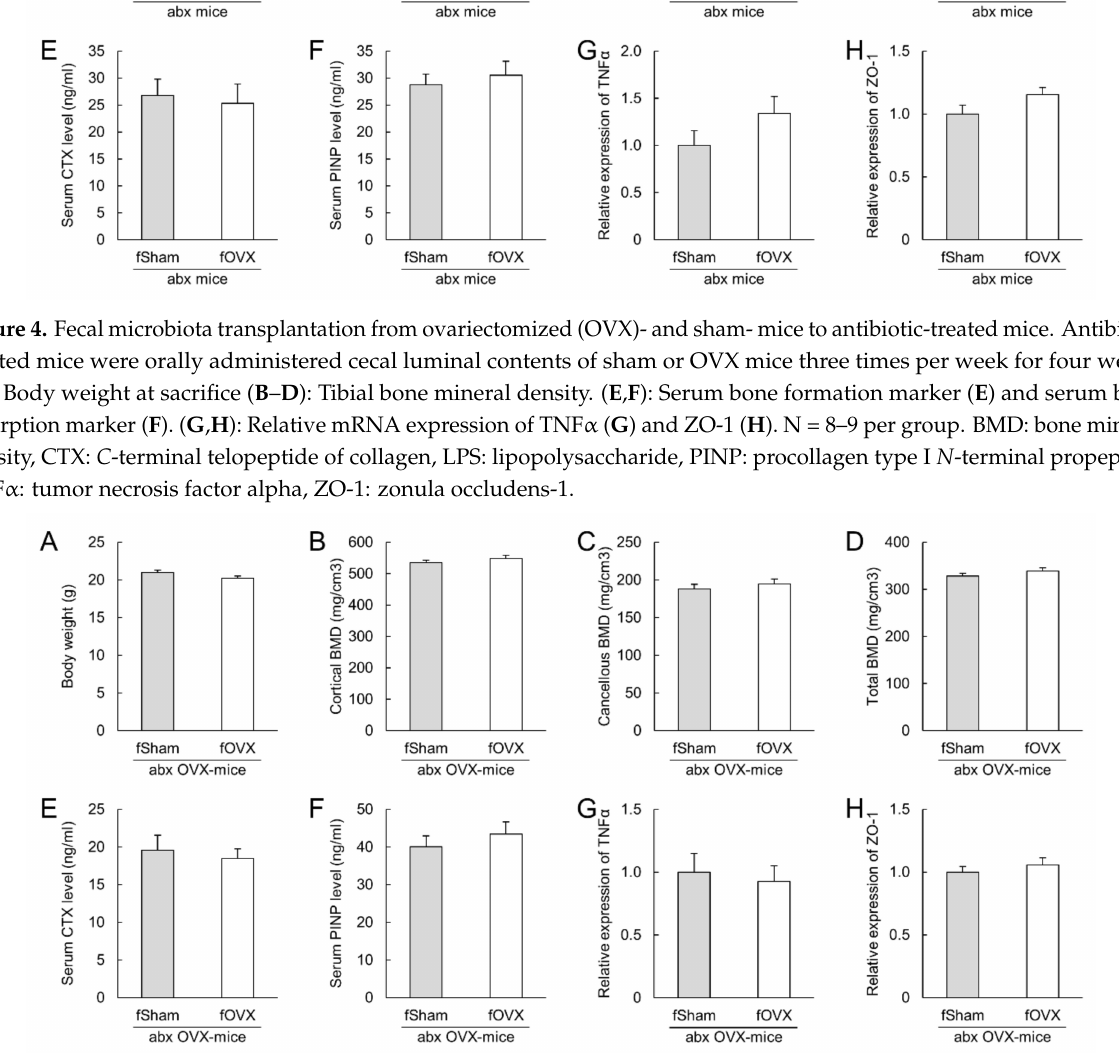
Figure 5. Fecal microbiota transplantation from ovariectomized and sham mice to antibiotic-treated ovariectomized mice. Antibiotic-treated mice were ovariectomized and orally administered cecal luminal contents of sham and ovariectomized mice three times per week for four weeks. ( A – F ): Body weight, tibial bone mineral density ( B – D ), serum bone formation marker ( E ), and serum bone resorption marker ( F ) at sacrifice. ( G , H ): Relative mRNA expression of TNF α ( G ) and ZO-1 ( H ). N = 6–7 per group. BMD: bone mineral density, CTX: C -terminal telopeptide of collagen, LPS: lipopolysaccharide, PINP: procollagen type I N -terminal propeptide, TNF α : tumor necrosis factor alpha, ZO-1: zonula